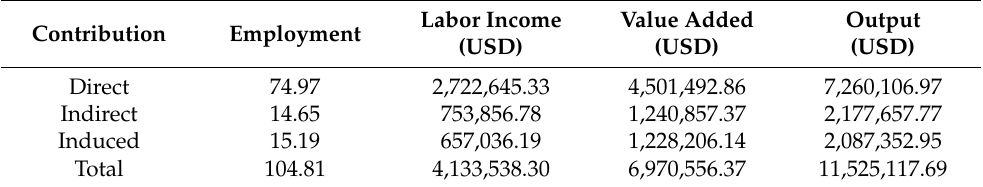
Table A10. Contribution of Rookery Bay Visitation to Lee and Collier Counties (Annual).